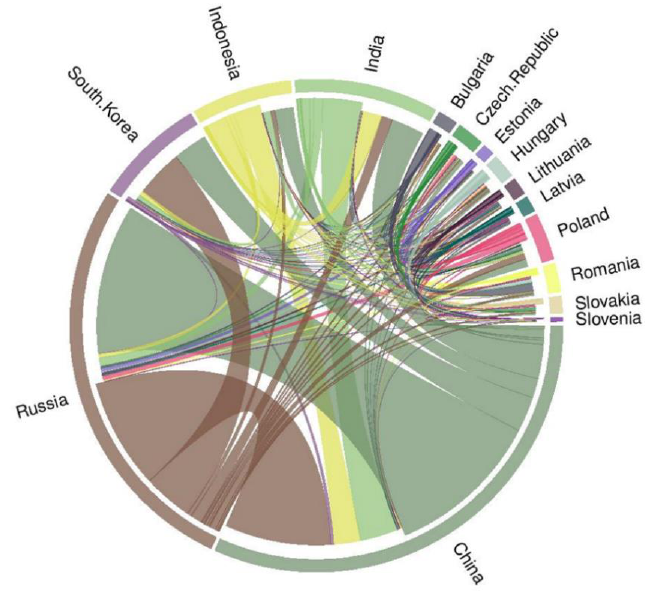
Figure 4. Interlinked relations of land use between the fifteen economies in trade (excluding RoW).